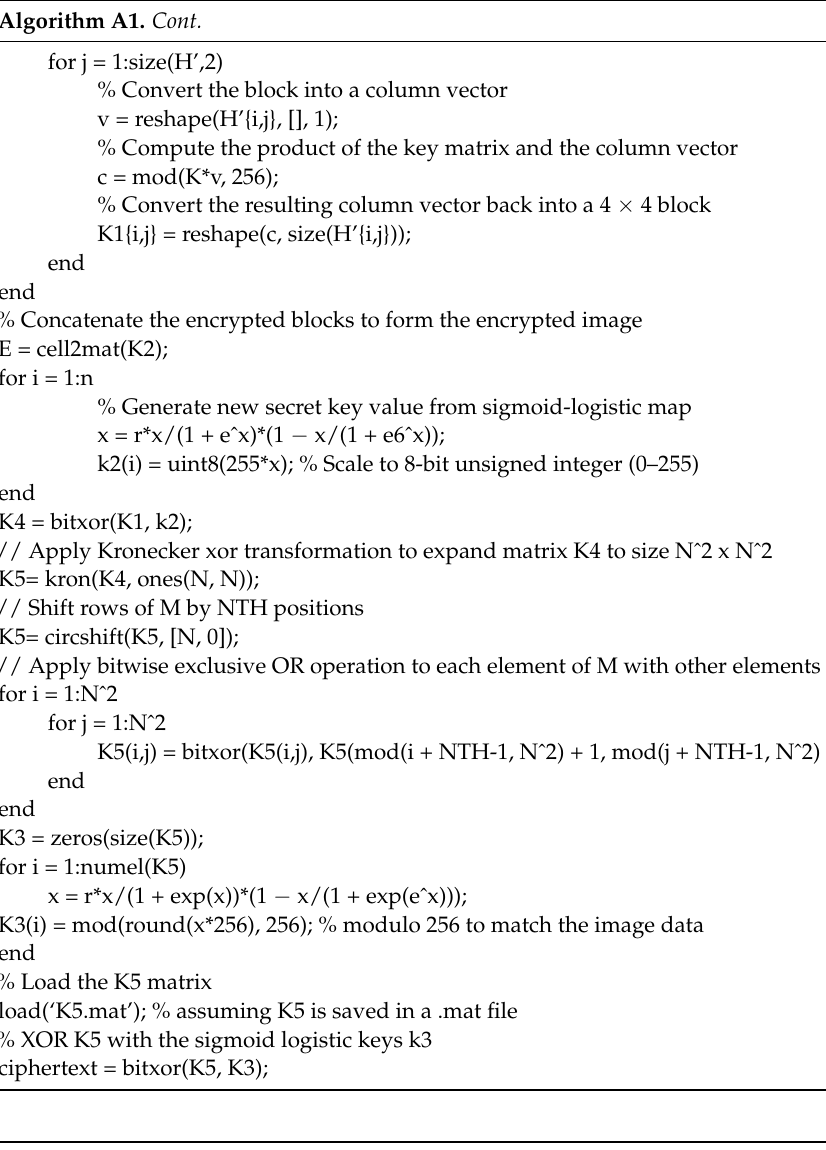
Algorithm A2. Decryption